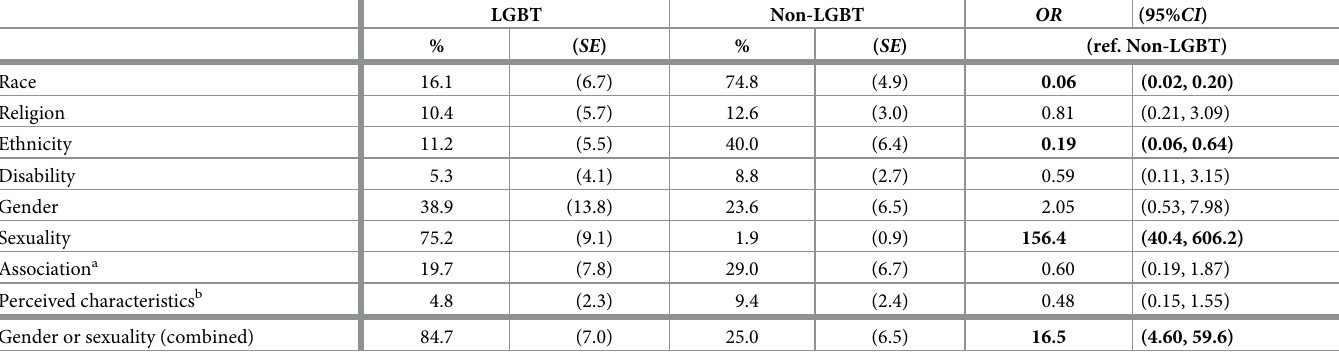
Table 1. The type of bias-motivation among hate crime victims, by sexual orientation and gender identity, United States, National Crime Victimization Survey